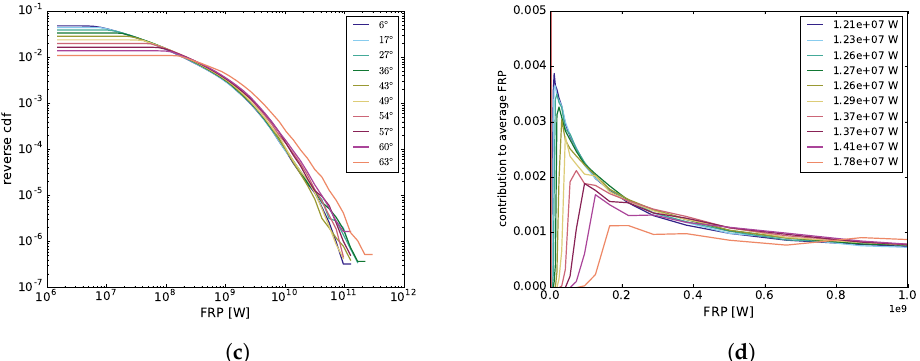
Figure A1. Statistical properties of MODIS gridded-FRP observations (hourly, 2017) after bias correction: ( a ) number of observations, ( b ) probability density function (PDF), ( c ) “reverse” Cumulative distribution function (CDF), ( d ) contribution to average gridded FRP. The gridded-FRP with 0.1 ◦ resolution are corrected according to the correction factors described in Figure 1, and then re-gridded to 1 ◦